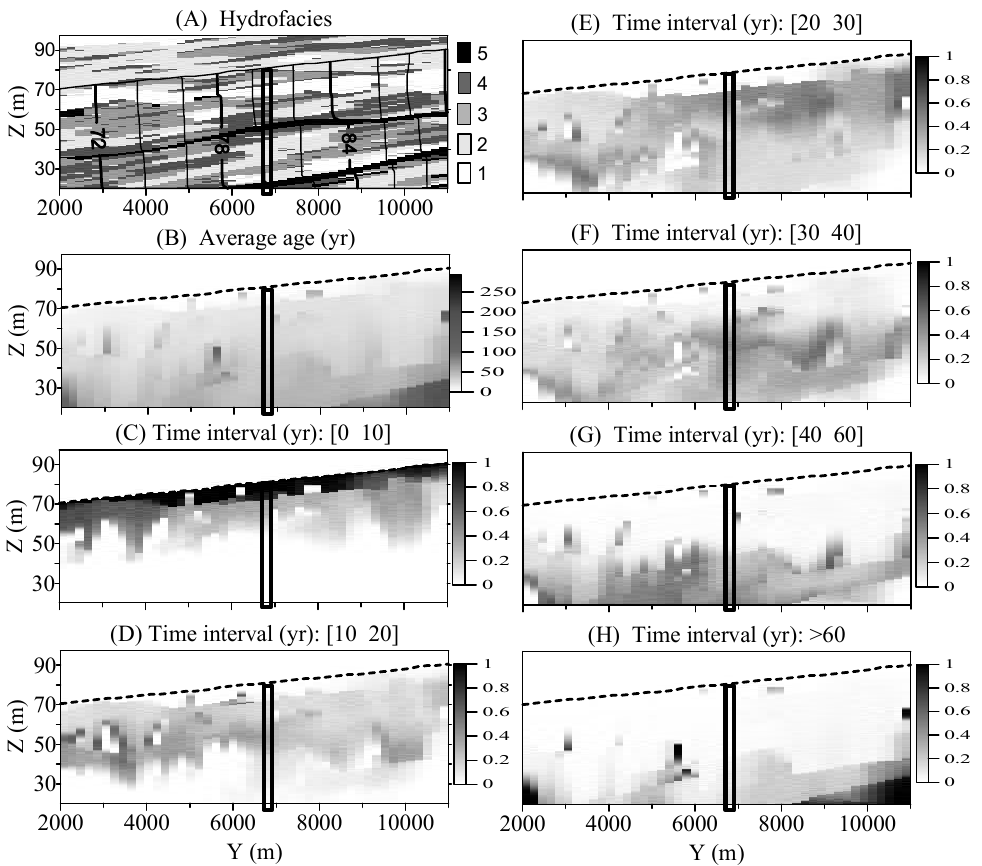
Figure 4. Sensitivity Maps for the vertical slice ( X = 7100 m) inside the IVF. The dashed line represents the water table. The thick, small rectangle represents the column used in Figures 6A and 7A. In ( A ) the hydrofacies 1, 2, 3, 4, and 5 represent gravel, sand, muddy-sand, mud and paleosol, respectively. The mean groundwater age with a unit year is shown in ( B ). The cumulative BTTPD within the time interval [0 10] yrs ( C ), [10 20] yrs ( D ), [20 30) yrs ( E ), [30 40] yrs ( F ), [40 60] yrs ( G ), and >60 yrs ( H ).